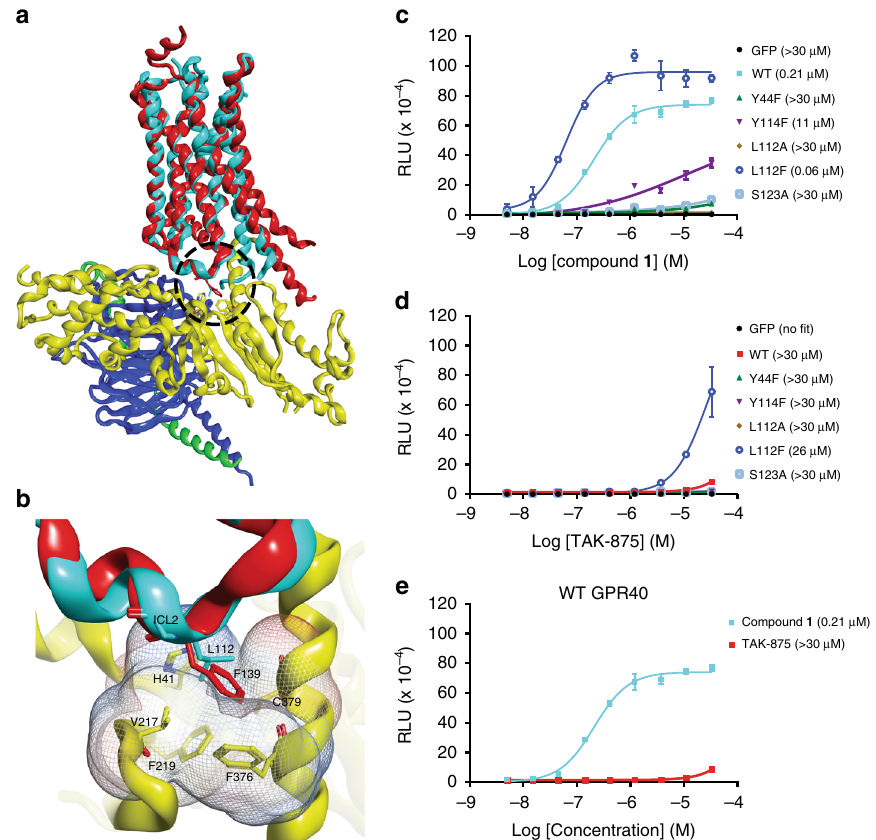
Fig. 6 Functional study on GPR40 site A2 mutants and intracellular loop 2 (ICL2) mutants. a Structural superposition of GPR40-compound 1 with β 2AR (cid:129) G protein complex (PDB: 3SN6) in ribbon representation (C α RMSD = 1.31 Å). GPR40-compound 1 structure is in cyan; compound 1 is shown as orange stick; β 2AR is in red; G α β is in purple; G γ is in green. The vdW interaction surface of the A2 binding site is shown as mesh in silver. The region s is in yellow; G circled is magni fi ed in b . b An important hydrophobic contact between the ICL2 of β 2AR and G α s . The ICL2 is labeled. vdW interaction surface formed by H41, V217, F219, F376, and C379 of the G α s is shown as mesh and colored according the electrostatic charge of the residues (red: negative; blue: positive; white: neutral). c , d cAMP accumulation assays in the presence of compound 1 (c ) or TAK-875 ( d ). Levels of cAMP are measured as relative luminescence units (RLU). Y114F, S123A, Y44F are site A2 mutations. L112A and L112F are ICL2 mutations involved in G α s coupling. n = 3. EC 50 values are shown in the parentheses. Error bars indicate s.e.m. e Measurements in WT extracted from c and d for ease of